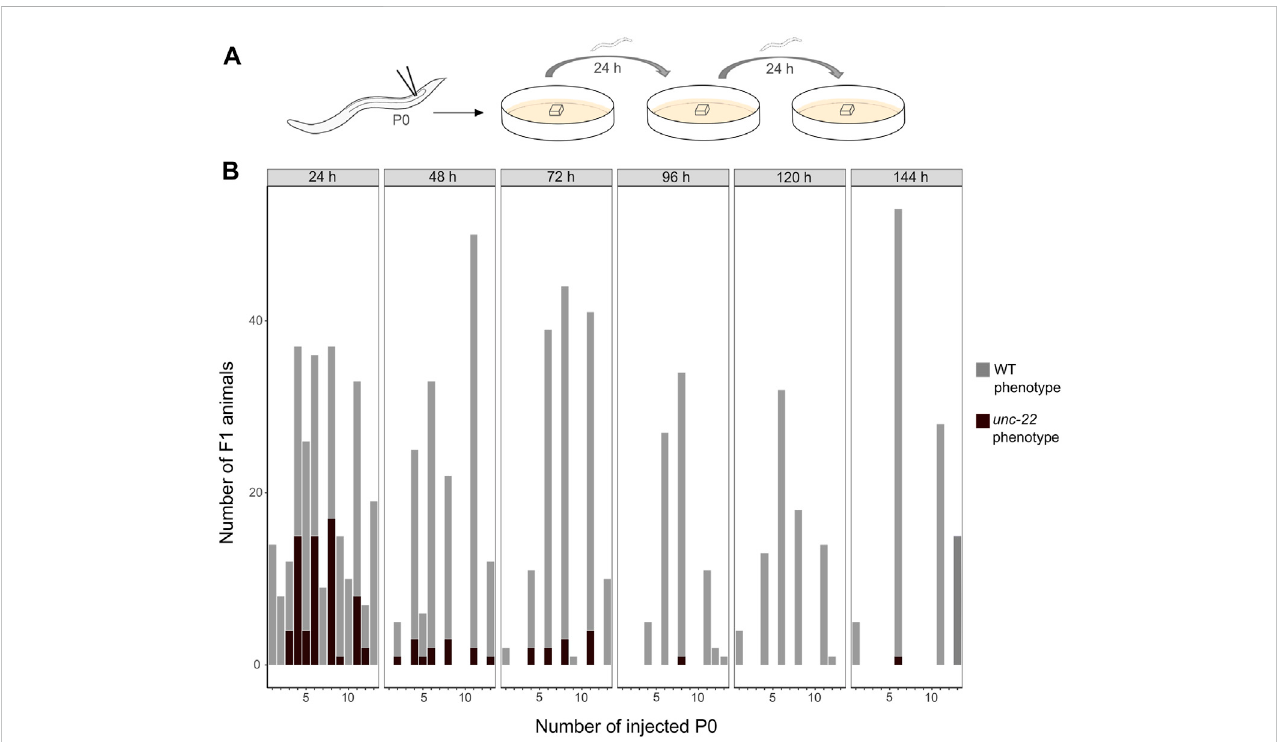
FIGURE 3 (A) Scheme of experimental work fl ow. Microinjection of adult P0 into gonad. Every 24 hindividual worms are transferred onto fresh agar plates covered by a slice of agar. (B) Number of F1 animals with wild-type (light grey) and twitching (dark grey) phenotype per injected P0 (15 worms were injected in total) in time intervals of 24 h for a total of 6